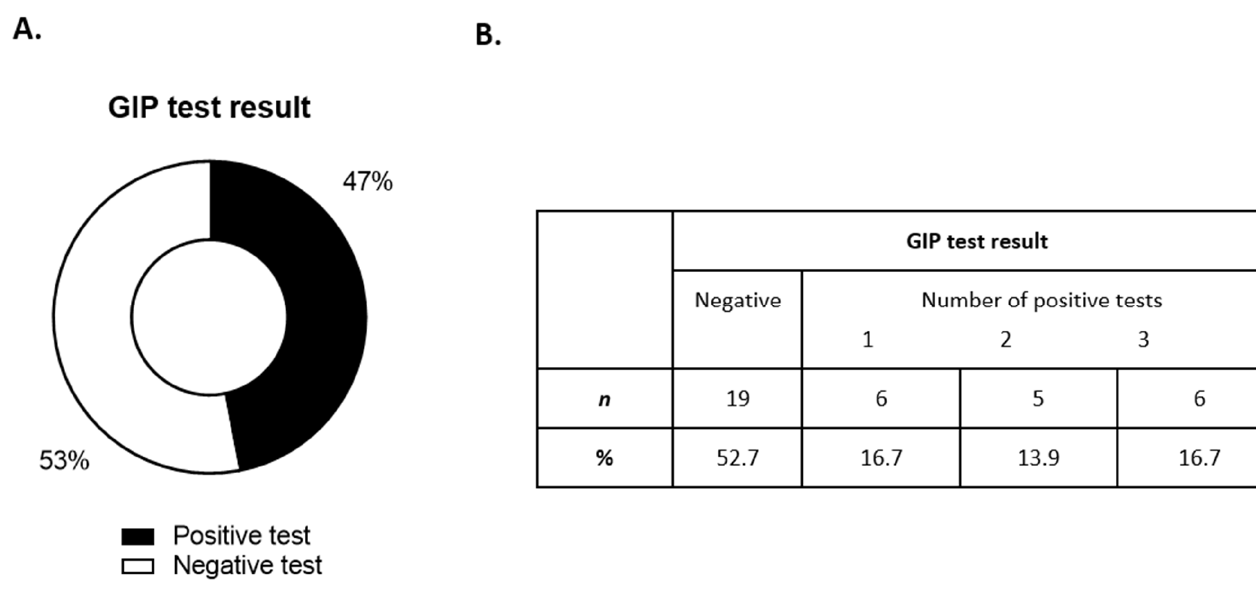
Figure 4. ( A ) Urine GIP testing schematic. Patients provided three urine samples in total—one from during the week and two from the weekend. ( B ) Example urine GIP immunochromatographic tests. If present, GIPs in the sample interact with monoclonal antibodies A1 and G12 on the test strip, producing a red line in the test zone [21]. An internal control generates a green line which indicates correct test performance [21].